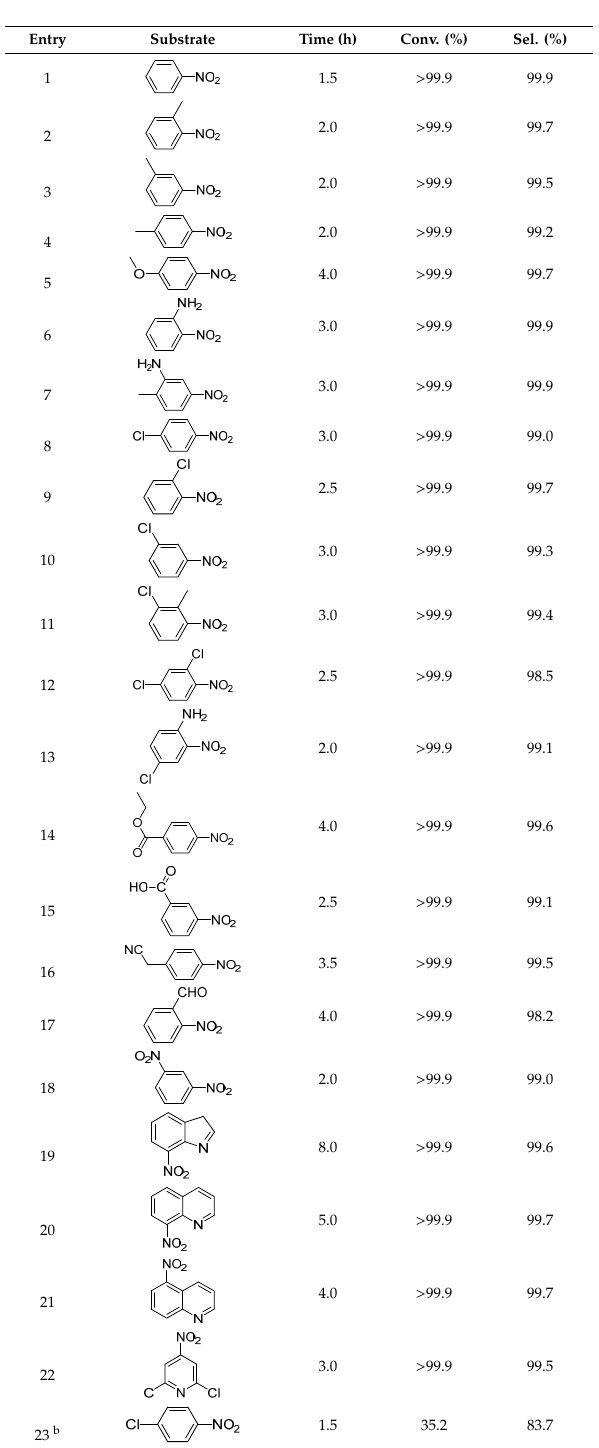
Recycle run Figure 5. Reuse tests of the Pt/N-CMK-3-2 catalyst. Reaction conditions: 80 mmol nitrobenzene, 40 mg catalyst, 20 mL of ethanol, 40 °C, 2 MPa H 2 , 1.0 h. 3. Experimental Section 3.1. Chemicals All chemicals were purchased and used without further purification. Pluronic P123 (EO 20 PO 70 EO 20 ) and tetraethylorthosilicate (TEOS) were bought from Sigma-Aldrich Reagent (Shanghai, China). Chloroplatinic acid hexahydrate (H 2 PtCl 6 ·6H 2 O), 2-methylimidazole, all nitro compounds, and solvents were supplied by Sinopharm Chemical Reagent Co., Ltd (Shanghai, China). 3.2. Catalyst Preparation Ordered mesoporous silica SBA-15 was obtained using P123 as a structure directing agent and TEOS as the silica source under acidic conditions according to the document [38]. CMK-3 was prepared using SBA-15 as the template and sucrose as the carbon source, and then was carbonized at 900 °C for 6 h under nitrogen, as described by Ryoo et al. [39]. The silica template was removed using 5 wt% hydrofluoric acid aqueous solutions at room temperature. The CMK-3 product was obtained after filtering, washing, and drying. The N-CMK-3 was prepared by an impregnation method with the following steps: 6 g of CMK-3 and a certain amount of 2-methylimidazole were dissolved in 60 mL deionized water at room temperature; the amount of 2-methylimidazole was 1,